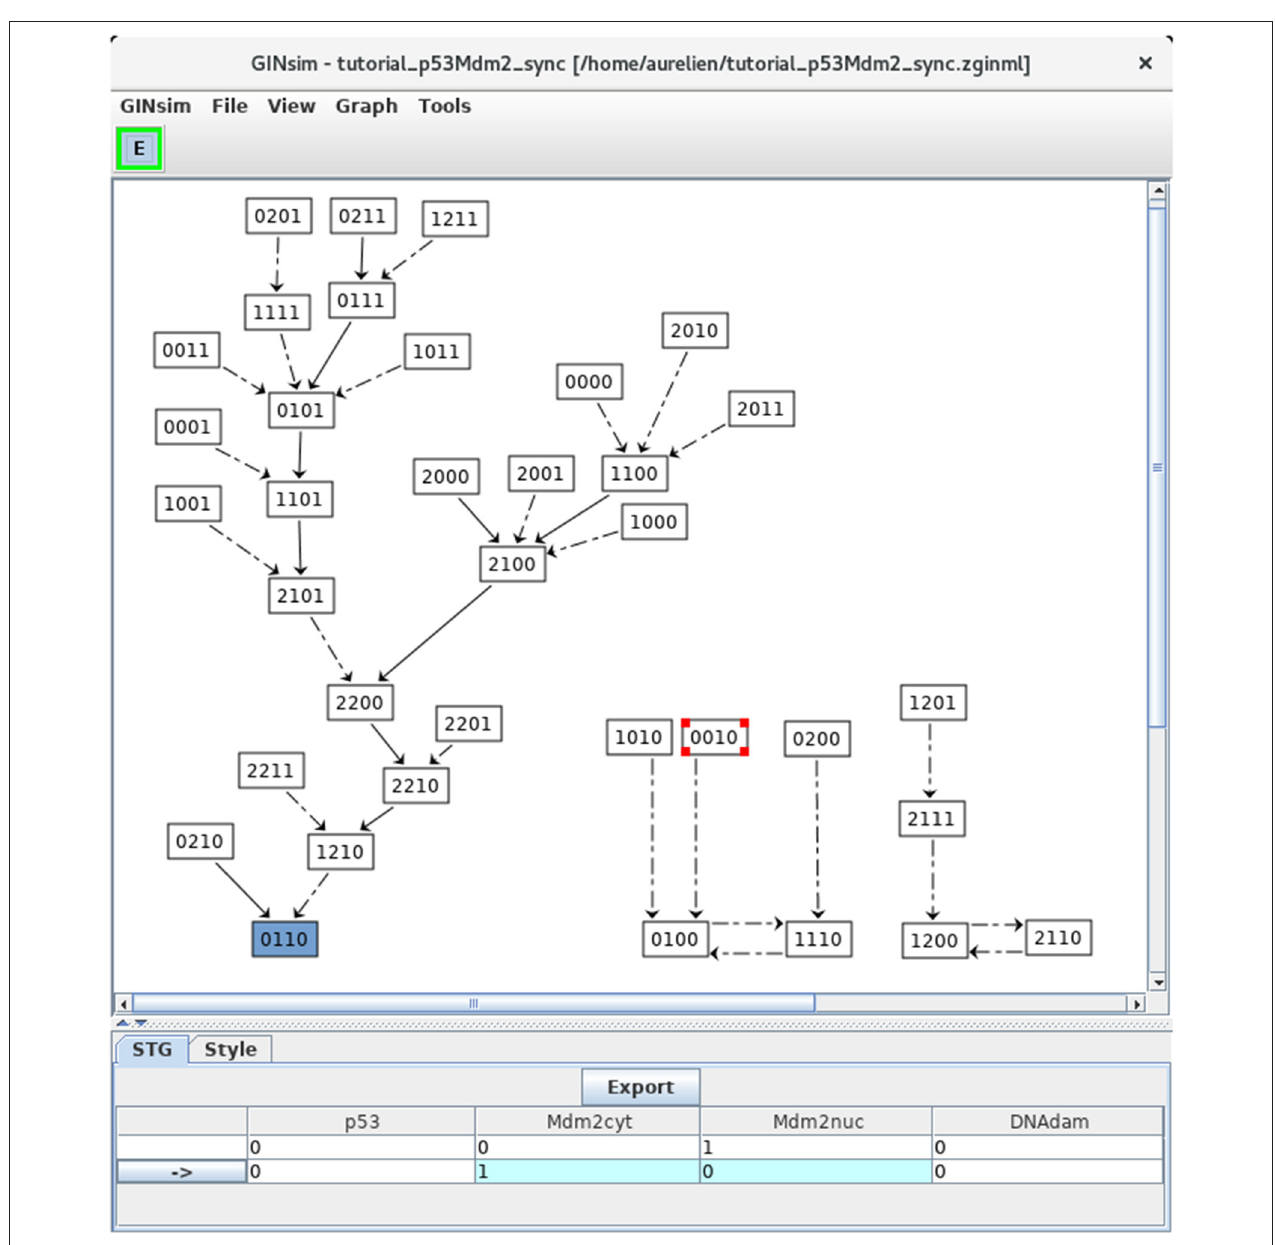
FIGURE 8 | Synchronous state transition graph for the p53-Mdm2 model. This STG has been generated with the simulation parameters shown in Figure 5 (without specifying any initial state, but using the synchronous updating scheme). Note that the layout has been manually rearranged for sake of clarity. The STG is composed of three non connected subgraphs. On the left, we find back the resting stable state 0110 , which can be reached from 26 other states. On the right, we see that the synchronous updating further generates two two-states cyclic attractors, which can be reached from three or two other states, respectively. Solid and dotted arrows denote single and multiple transitions,